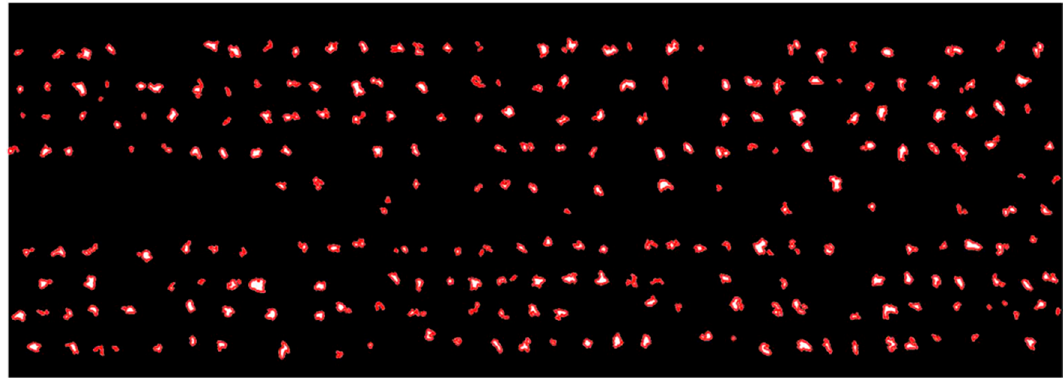
Figure 9. Image after using the Color Thresholder App of MATLAB. Selecting the yellow and lime green pixels of the image with the decorrstretch contrast enhancement procedure as shown for plot number 12.